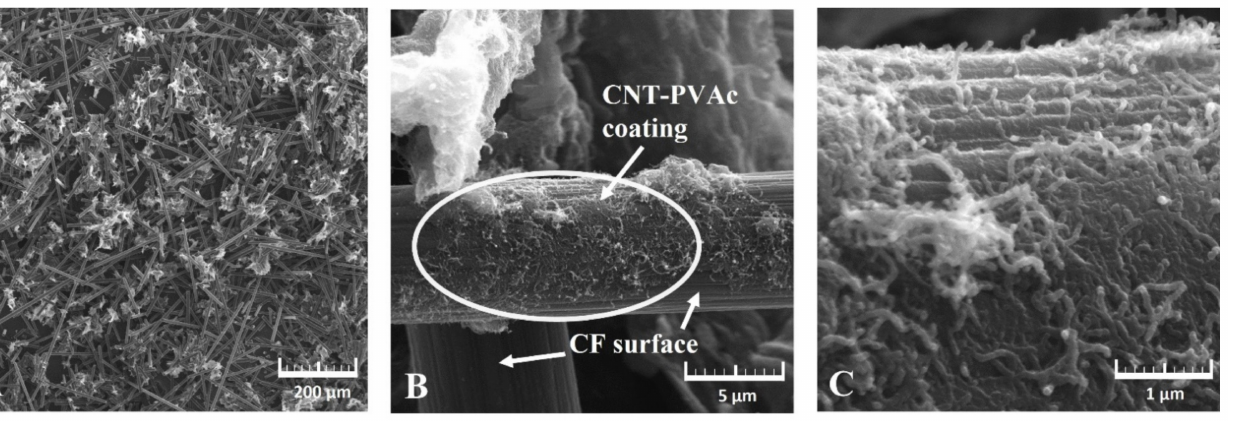
Figure 2. SEM images of carbon hybrid filler CF/CNT-PVAc (( A )—mag. 200 × ; ( B )—mag. 10 k × ; ( C )—mag. 50 k × ).